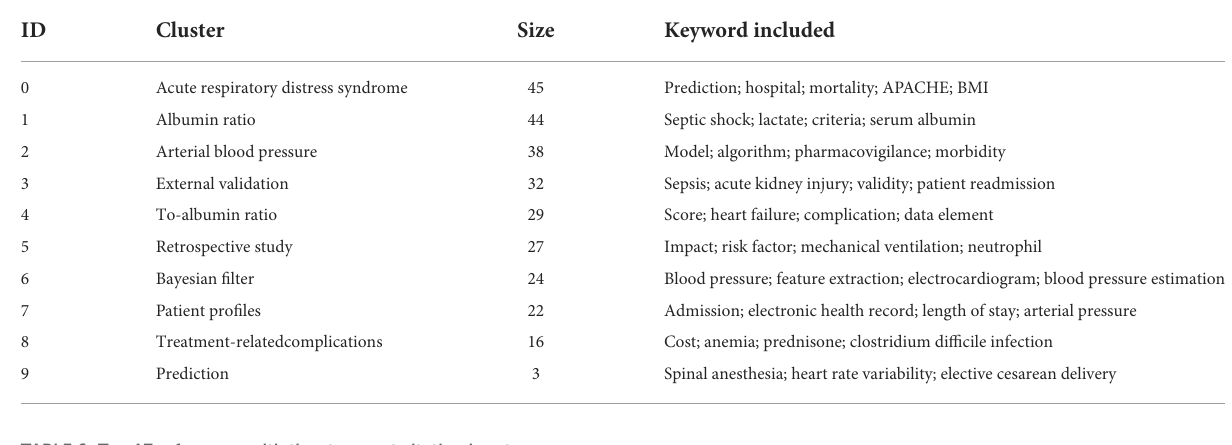
TABLE 5 Top 9 clustering and keywords included in each cluster.